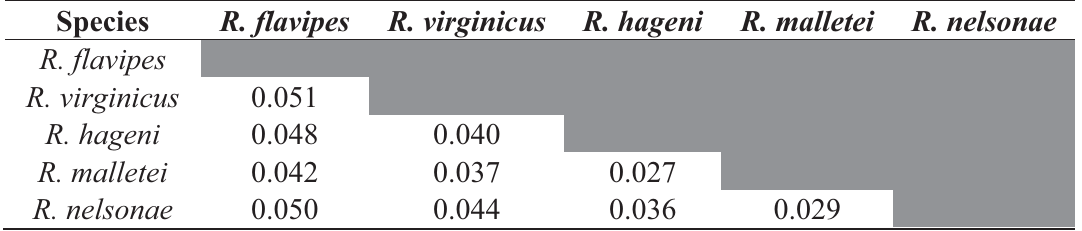
Table 5b. Estimate of net evolutionary divergence between species for